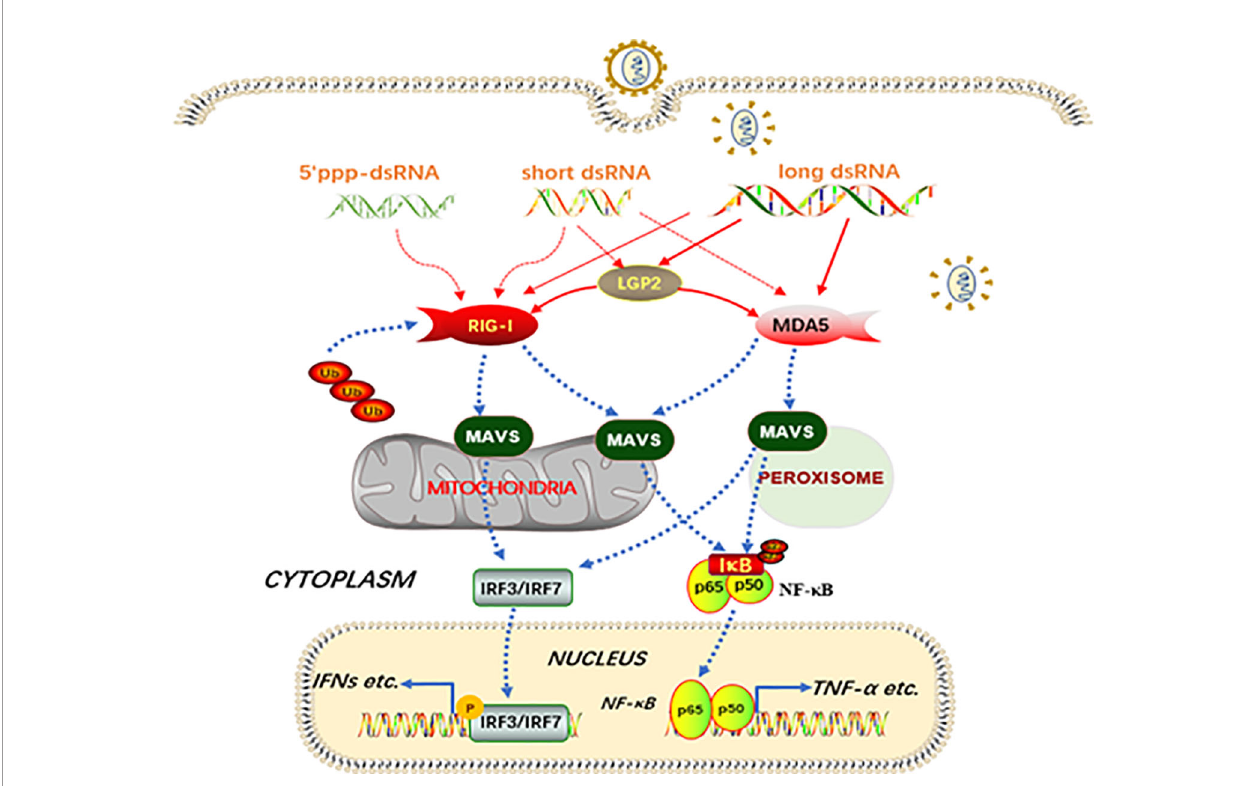
FIGURE 10 | Schematic diagram of porcine RIG-I and MDA5 signaling and the regulation by LGP2. Porcine RIG-I and MDA5 similarly recognize dsRNA and sense viruses regardless of the lengths of dsRNA and the af fi nity of binding to dsRNA, to trigger downstream signaling and gene transcription. The porcine LGP2, binding with dsRNA in a similar way to MDA5, is able to promote the dsRNA binding by both MDA5 and RIG-I, and thus downstream signaling. Intriguingly, during the positive regulation by LGP2, the ATPase hydrolysis and dsRNA binding activity seem dispensable. The solid lines refer to con fi rmed interactions in this study, whereas the dashed lines are based on previous